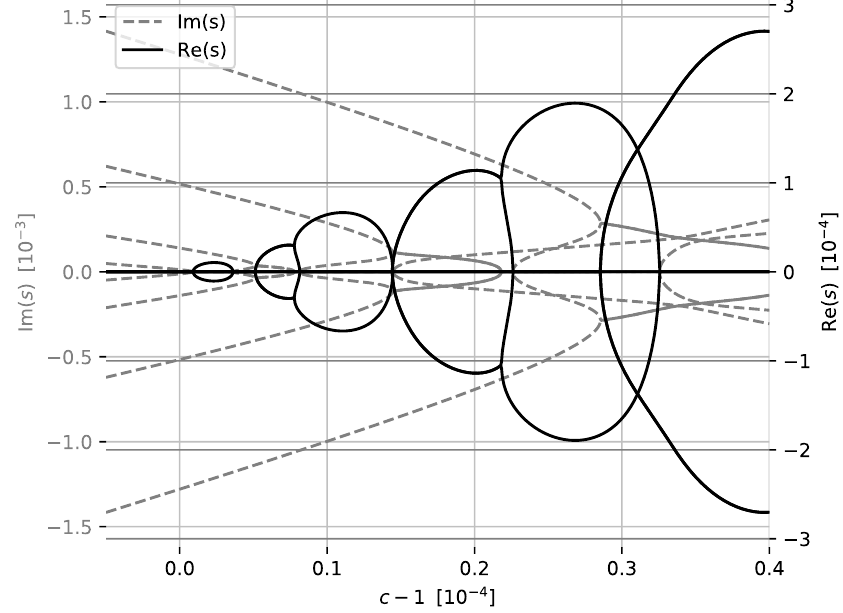
Figure 3. Stability exponent s as a function of the non-dimensional axial drive velocity c . No axial stream, v ∞ = 0.